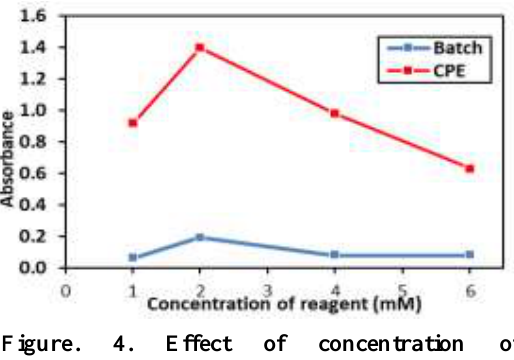
Figure. 4. Effect of concentration of sulfadimidine (conditions for CPE: incubation time, 30 min; volume of surfactant (10%v/v), 1 ml; HCl, 0.1 M) Influence of type and concentration of base solution The preliminary experiments indicated that the suggested coupling reaction must be carried out in alkaline medium. In order to activate the phenolic group of ISX, the alkaline medium improves and promotes the coupling reaction by transforming ISX to phenoxide species. Various alkalies (NH 4 OH, NaOH, and Na 2 CO 3 ) were considered and the results displayed that sodium hydroxide gave the best analytical response (Fig.5a). The influence of series of NaOH concentrations ranged from 0.06-0.4 M on absorbance of azo-dye was examined. Maximum response was obtained when used 0.1 M of NaOH (i.e. 0.5 ml of 2 M in 10 ml final volume) with and without extraction